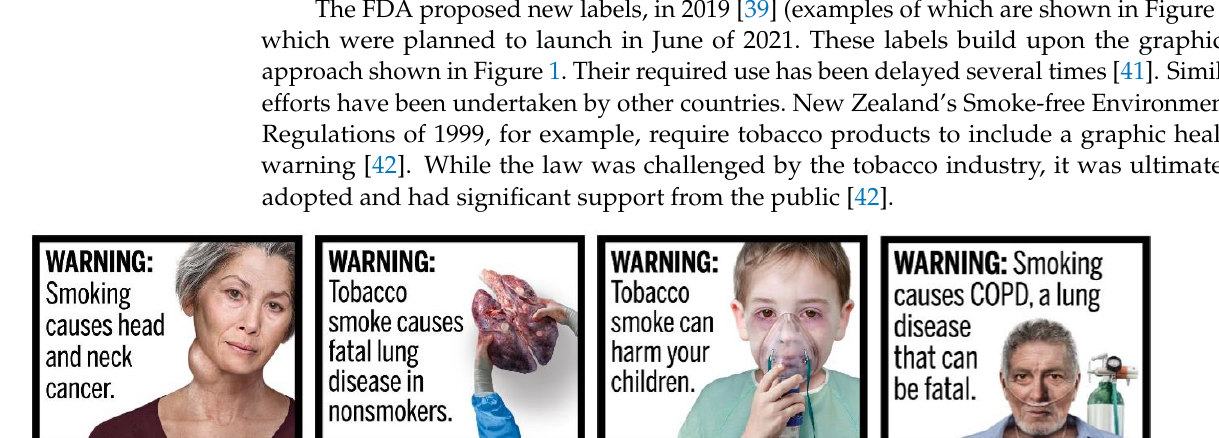
Figure 2. Example of the FDA’s proposed cigarette labels in 2011 [40].